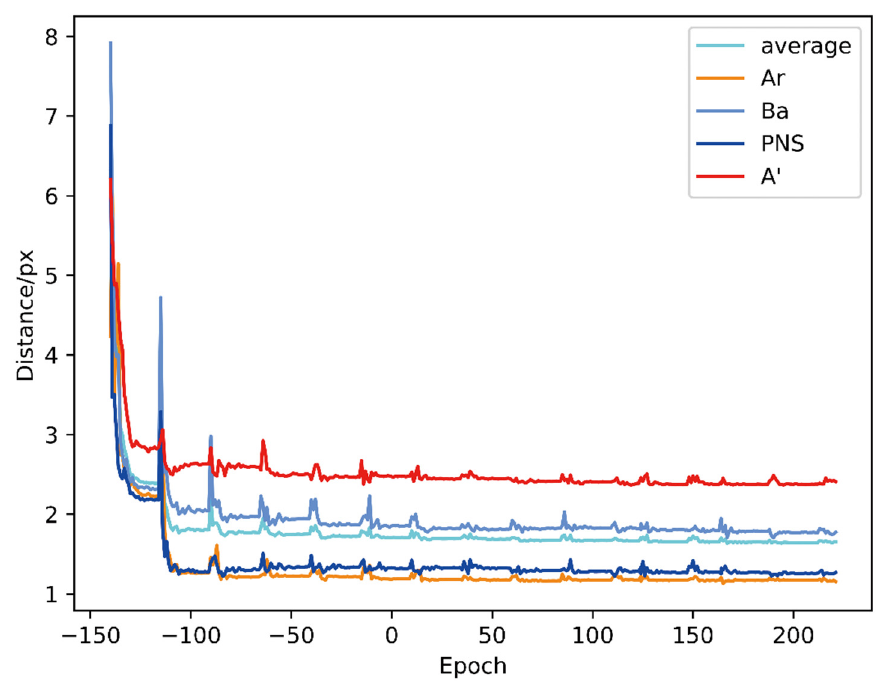
Figure 5. Changes in absolute distance between ground truth and predicted point (in pixels).